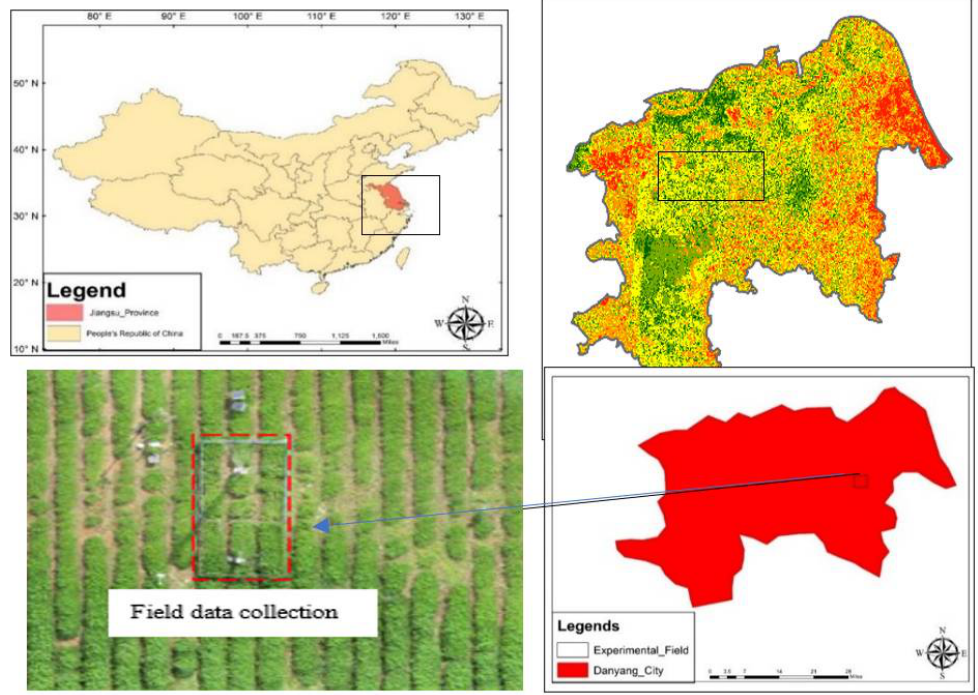
Figure 1. Study map of the experimental site.